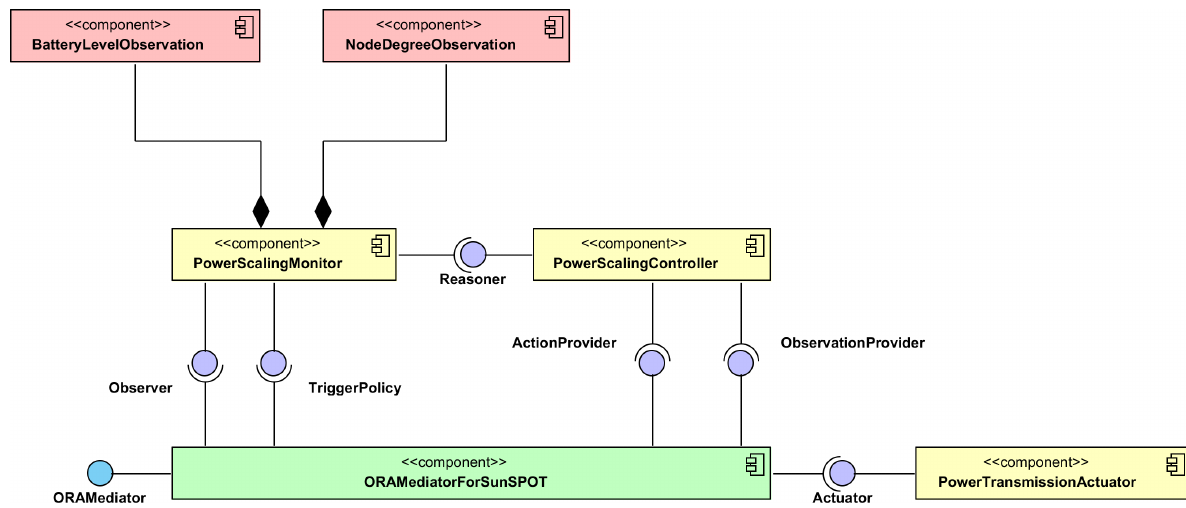
Software components accomplishing the self-adaptive system improving the energy consumption while keeping the communication